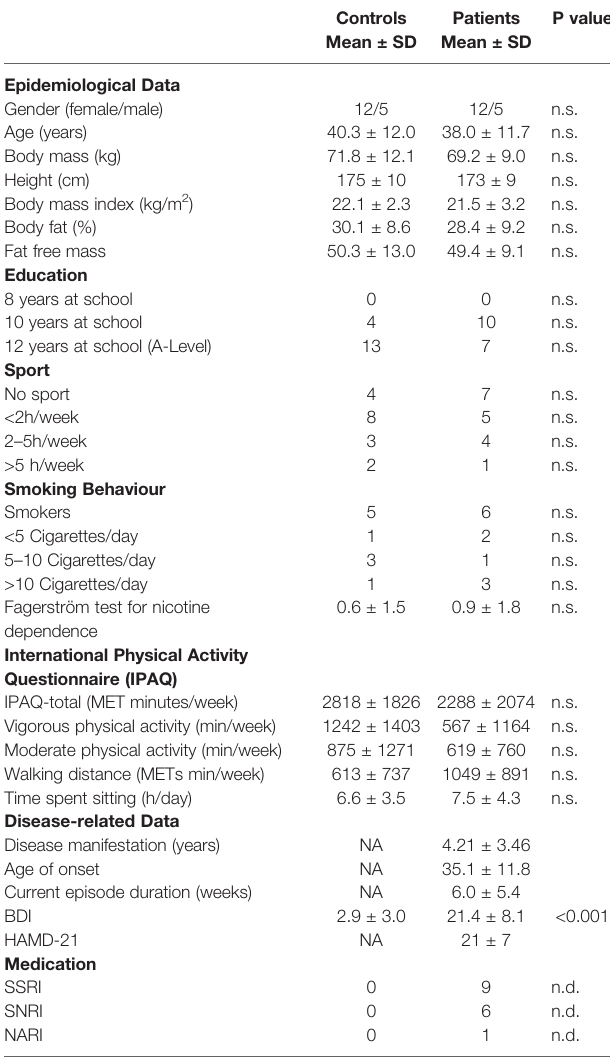
TABLE 1 | Epidemiological and clinical characteristics of participants.